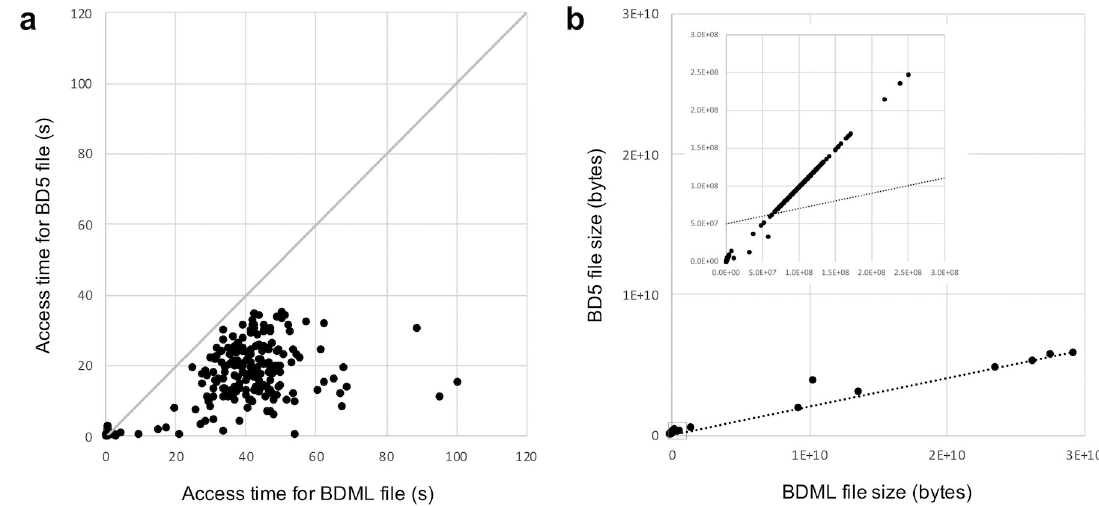
Fig 8. Comparison between the BD5 and BDML data formats. a) Access times of the BDML and BD5 files. Access time was measured as the time for accessing and displaying xyz -coordinate data at a randomly selected time point stored in the BDML and BD5 files. The time was measured on an Intel Xeon CPU 2.8 GHz processor with 32 GB of main memory. Each dot represents a biological quantitative dataset. We used 334 biological quantitative datasets, each of which has coordinate data and is stored in SSBD:database as a single BDML file. BD5 files were generated from the BDML files by using the BDML2BD5 program. b) Size of the BDML and BD5 files. Each dot represents a biological quantitative dataset. In this comparison, we used 347 biological quantitative datasets, each of which was produced by bioimage informatics techniques and is stored in SSBD:database as BDML file(s). As above, the BD5 files were generated from the BDML files by using the BDML2BD5 program. The dashed line represents the linear regression line for all dots. The data within the small rectangle near the origin in the large graph is plotted on expanded axes in the